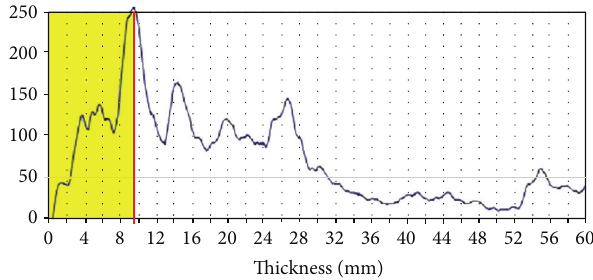
Figure 5: An A-mode ultrasound graph of an abdominal scan. Signal amplitude is on the 𝑦 -axis and tissue depth is on the 𝑥 -axis. The shaded area represents the subcutaneous fat, in this case about 9.5